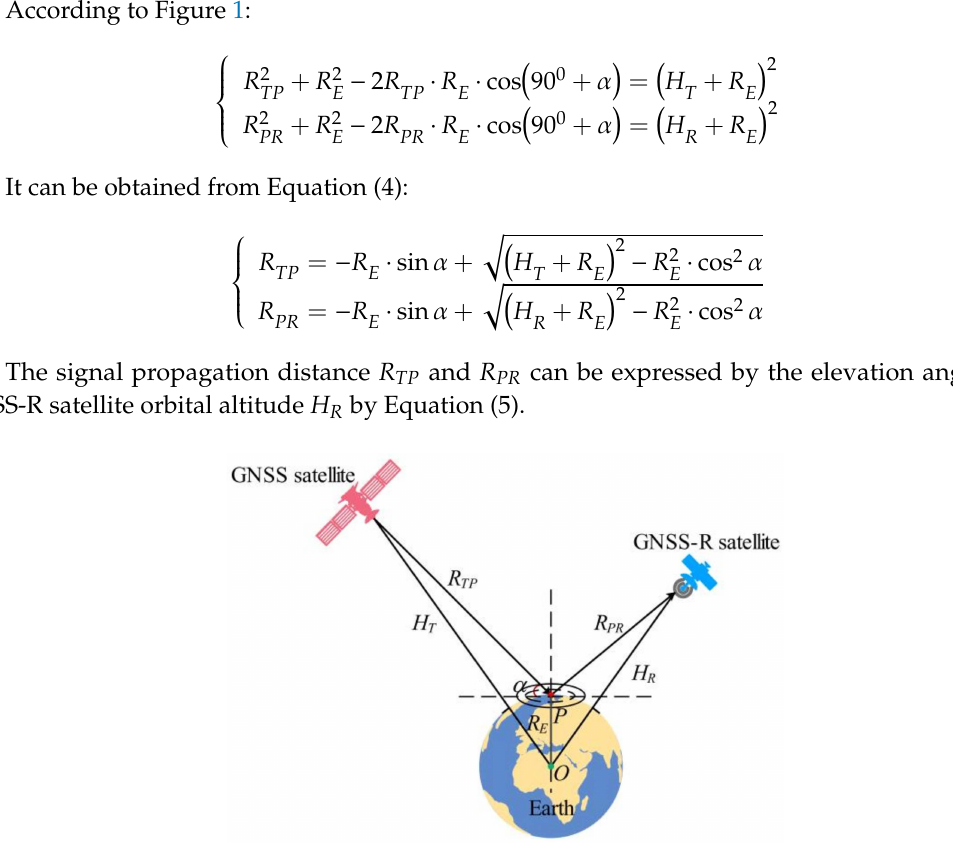
Figure 1. The GNSS-R specular point positioning geometry, where O is the geo-center, P is the position of the specular point, α is elevation angle, R E is Earth radius, H T and H R are the satellite orbital altitude of GNSS and GNSS-R, respectively. R TP is the signal transmission distance from GNSS satellite to the specular point, R PR is the signal reception distance from GNSS-R satellite to the specular